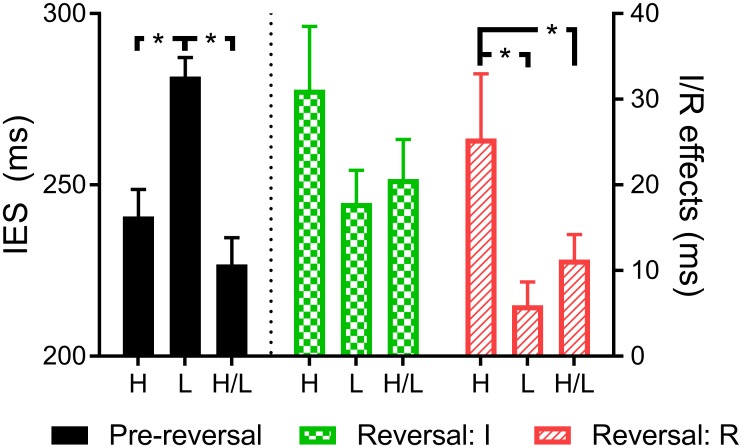
Summary of results.H, L and H/L denote high, low and high/low time-pressure conditions. Error bars represent standard errors of the mean. Black bars on the left side of the figure show mean RTs for correct responses in the Pre-reversal phase (left Y-axis). The rest of the bars show data for the Partial reversal phase; these results are the magnitude of the reversal effects (i.e., right Y-axis scores). Checked bars show the Instruction advantage results (I effect), while striped bars show the Reversal interference results (R effect; see main text for a description on how these effects were calculated). Lines and asterisks show significant between-group differences. Notably, while time pressure clearly affected Pre-reversal results and the R effect, it did not exert any influence on the I effect (all ps > .25).